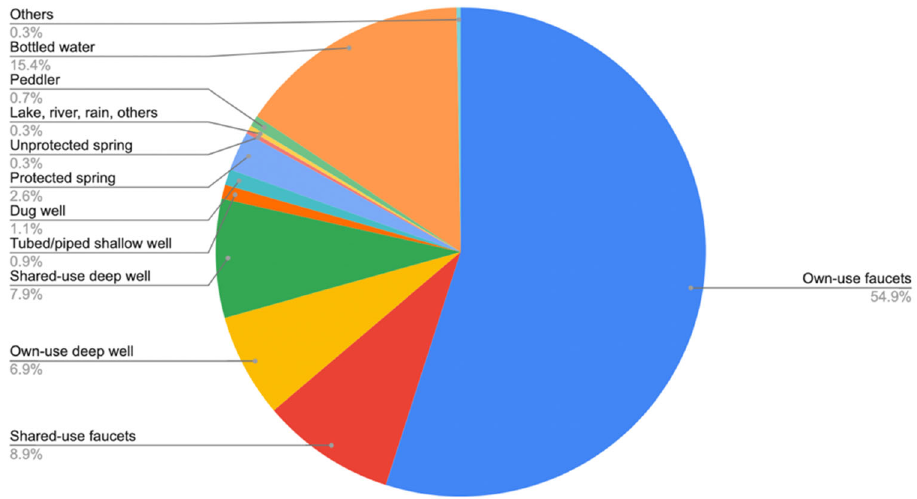
Figure 1. Point sources of drinking water supply in Batangas Province .